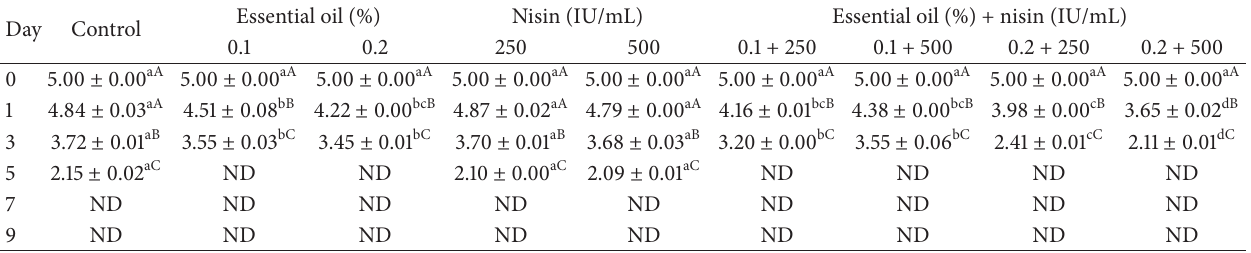
a Means with different lowercase letters in the same row are significantly different ( 𝑝 < 0.05 ). A Means with different capital letters in the same column are significantly different ( 𝑝 < 0.05 ). ND: not detected. Table 3: Acceptability scores (odour and flavour) of Doogh samples for different treatments. Day